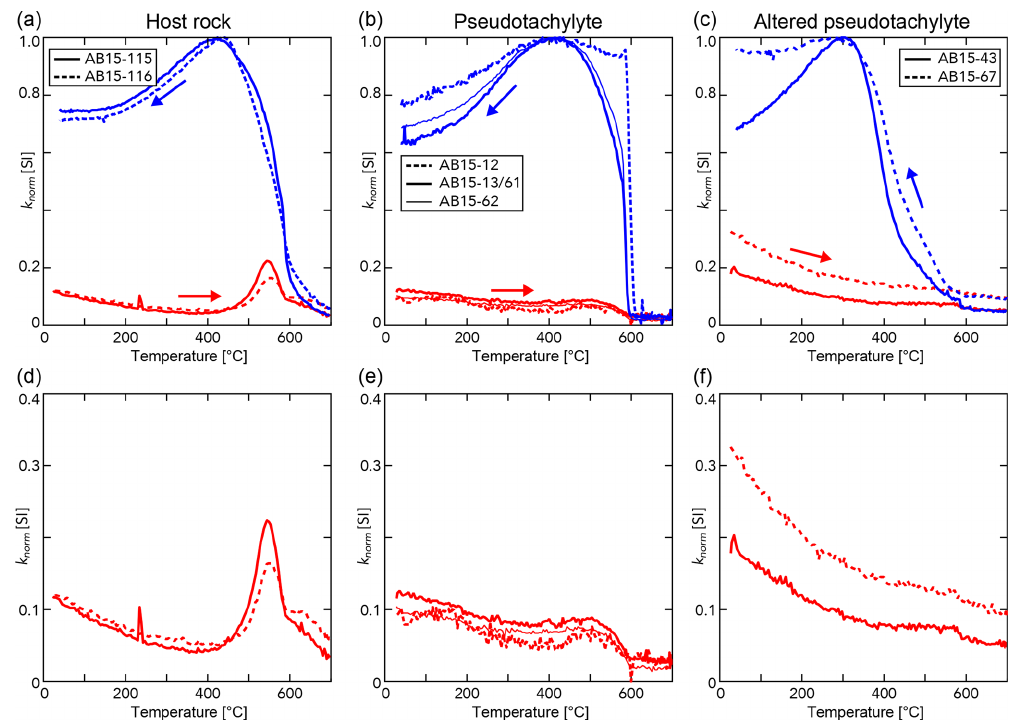
Figure 10. (a–c) Thermomagnetic curves for host rock, pristine and altered pseudotachylyte during heating from room temperature to 700 ◦ C (red curves) and cooling back to room temperature (blue curves). Susceptibility measurements ( k norm ) were normalized based on the highest value of each sample during the experiment. For increased visibility of the heating curves, (d) – (f) show only the heating curves for the same specimens shown in (a) – (c)